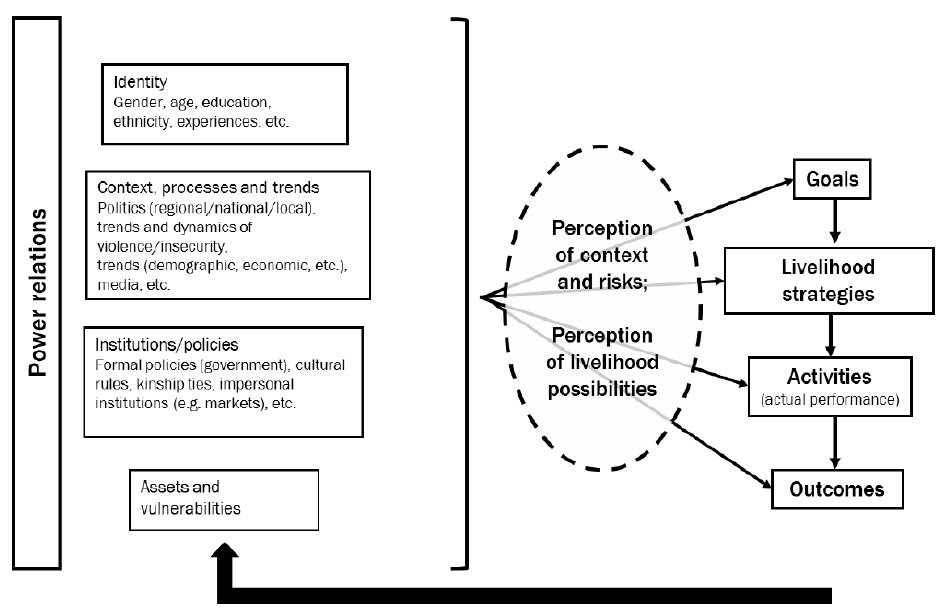
Figure 2. An operational map for research using a SLF. Source: [4] .